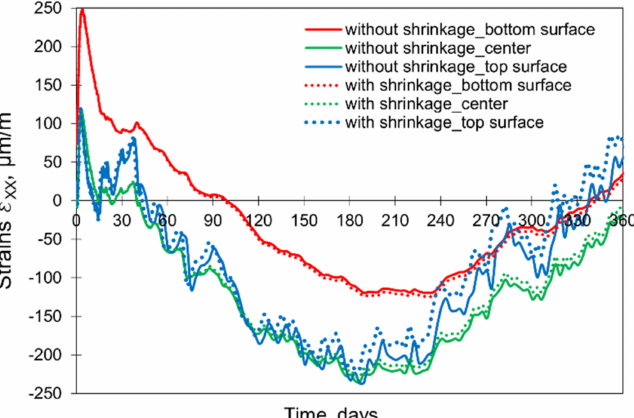
Figure 22. The influence of the shrinkage on the induced strains ε xx